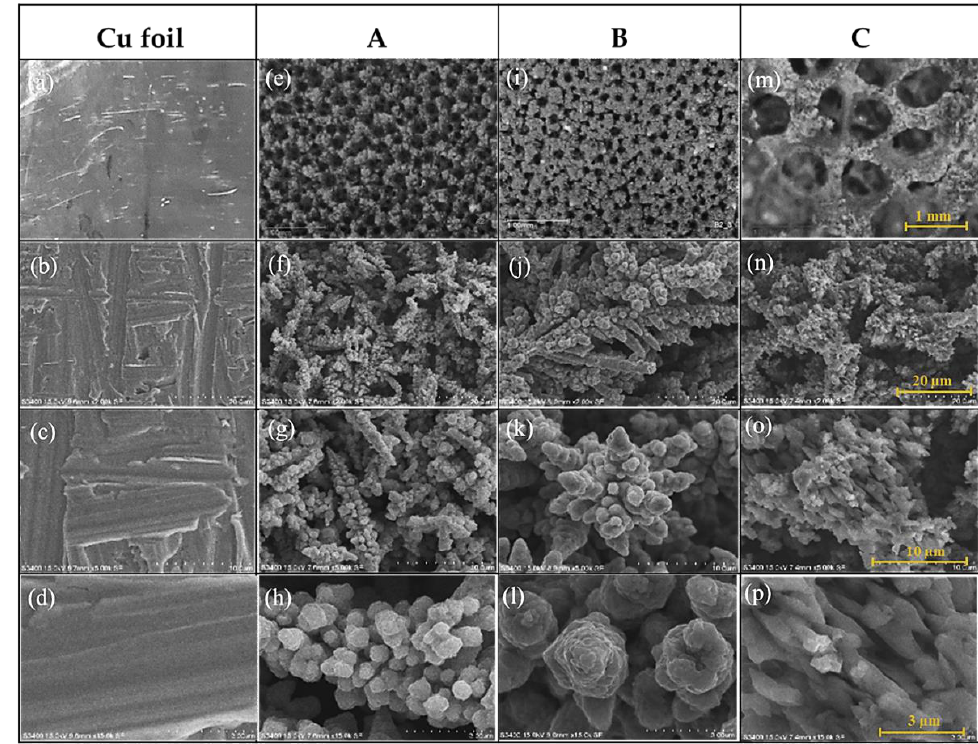
Figure 4. Microstructure of Cu foil ( a – d ), and porous Cu deposits from groups A ( e – h ), B ( i – l ), and C ( m – p ), electrodeposited with 3 A/cm 2 for 40 sec, presented at different magnifications. As shown in the micrographs of the samples in group C ( Error! Reference source not